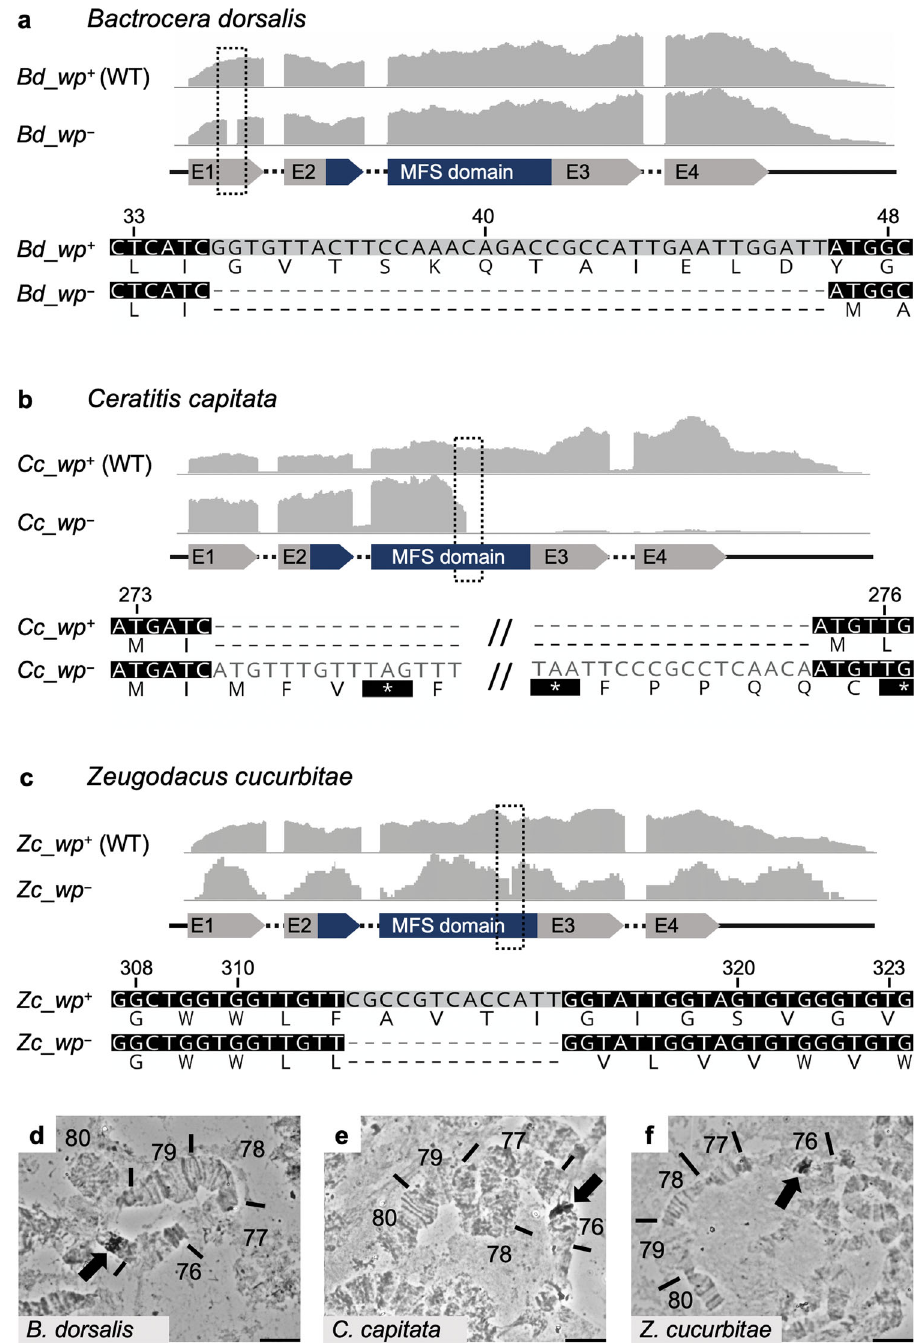
Fig. 3 Identi fi cation of the wp mutation in the transcriptomes of B. dorsalis , C. capitata, and Z. cucurbitae . The gray graphs show expression pro fi les from the candidate wp loci in WT ( wp + ) and mutant ( wp − ) fl ies at the immobile pupae stages of a B. dorsalis , b C. capitata , and c Z. cucurbitae . The gene structure (not drawn to scale) is indicated below as exons (arrows labeled E1 – E4) and introns (dashed lines), the Major Facilitator Superfamily (MFS) domain is shown in blue. The positions of independent wp mutations ( Bd : 37 bp deletion, Cc : approximate 8150 bp insertion, Zc : 13 bp deletion) are marked with black dashed boxes in the expression pro fi les and are shown in detail below the gene models based on de novo assembly of RNAseq data from WT and white pupae phenotype individuals (nucleotide and amino acid sequences). Deletions are shown as dashes, alterations on protein level leading to premature stop codons are depicted as asterisks highlighted in black. In situ hybridization on polytene chromosomes for d B. dorsalis , e C. capitata , and f Z. cucurbitae con fi rmed the presence of the wp locus on the right arm of chromosome 5 in all three species (arrows in micrographs). In situ hybridizations were done at least in duplicates and at least ten nuclei were analyzed per sample, scale bar = 10 µ m. The source data underlying Fig. 3d – f are provided as a Source Data fi